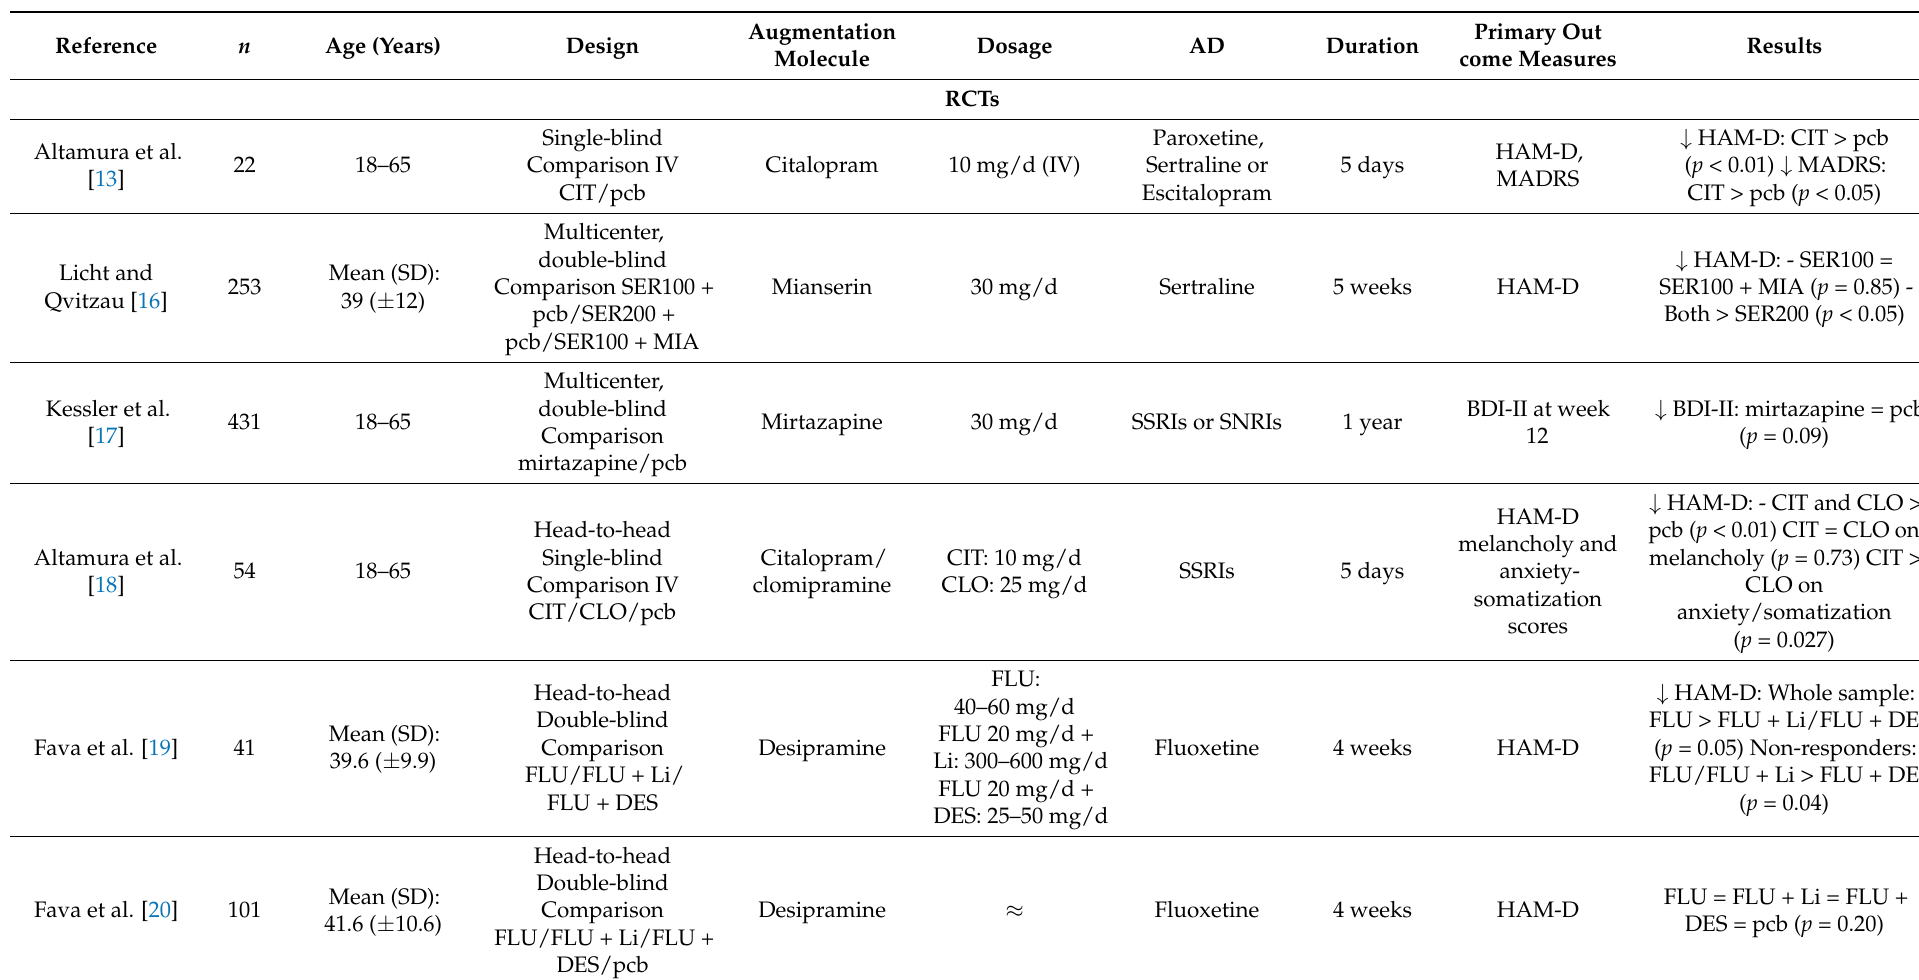
Table 1. Summary of the studies about augmentation with other ADs and buspirone in